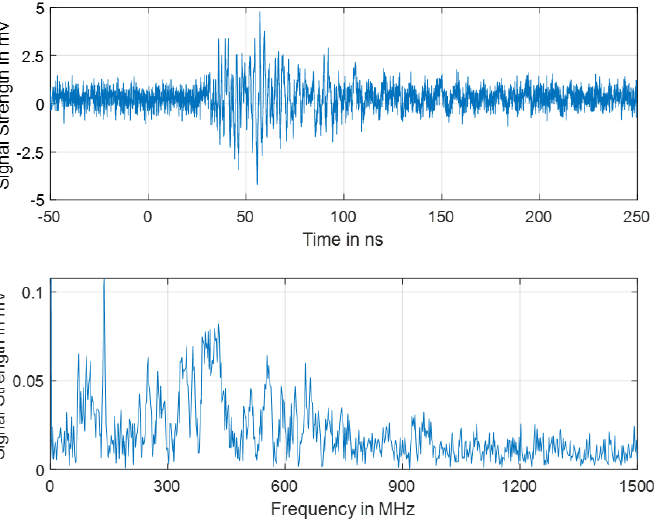
Figure 14. Time ‐ domain signal and frequency spectrum of the same signal obtained from sensor 2. Figure 14. Time-domain signal and frequency spectrum of the same signal obtained from sensor